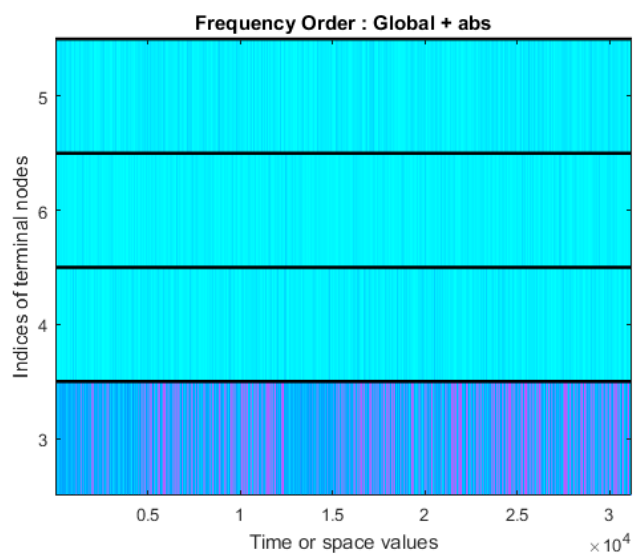
Figure 7. The wavelet packet spectrum of the bending moment for surface quality level 4.